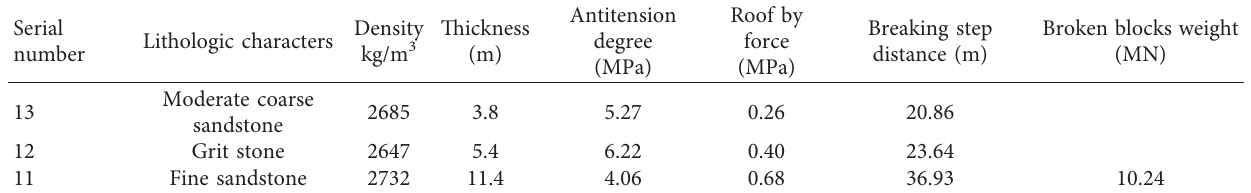
Table 6: The physical and mechanical characteristics of the hinged roof structure of No. 8218 large mining height working face.